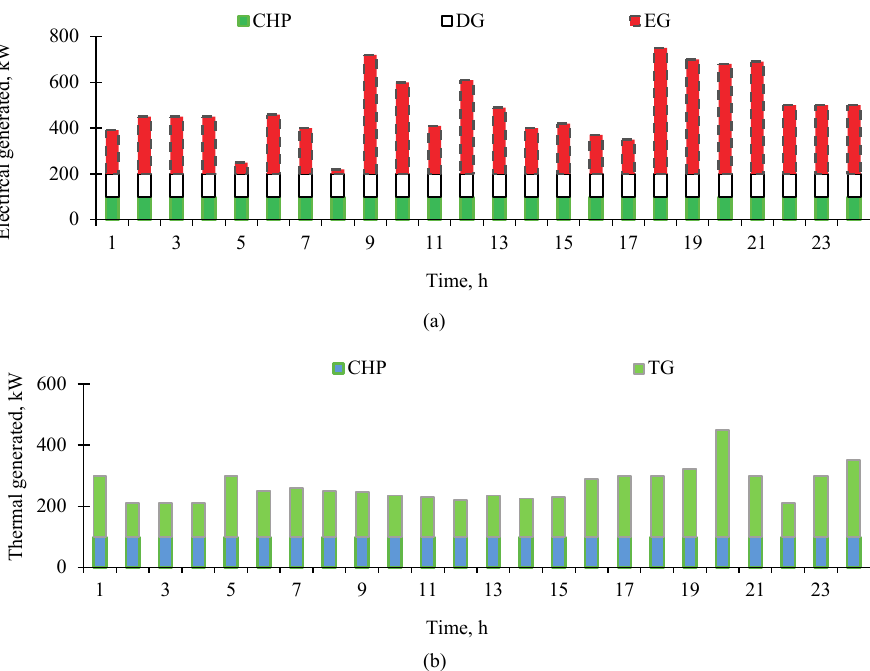
Fig. 7. Energy generation in Case A: (a) Electrical generated and (b) thermal